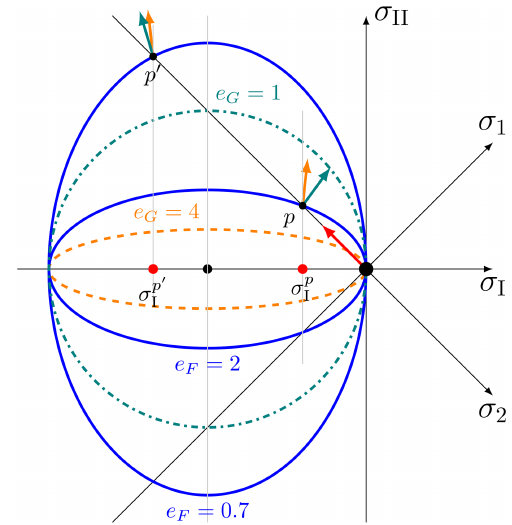
Figure 4. Trajectory of maximum normal stress (red arrow) in a uni-axial loading test experiment in a material with two different elliptical yield curves (blue) and plastic potentials (dashed orange and dash-dotted teal). The orange and teal arrows show the flow rule normal to the plastic potential of the same color for the same stress state. For e G < e F , the ratio of divergence to shear increases. The opposite is true for e G > e F . A similar figure in principal stress space is presented in Ringeisen et al.